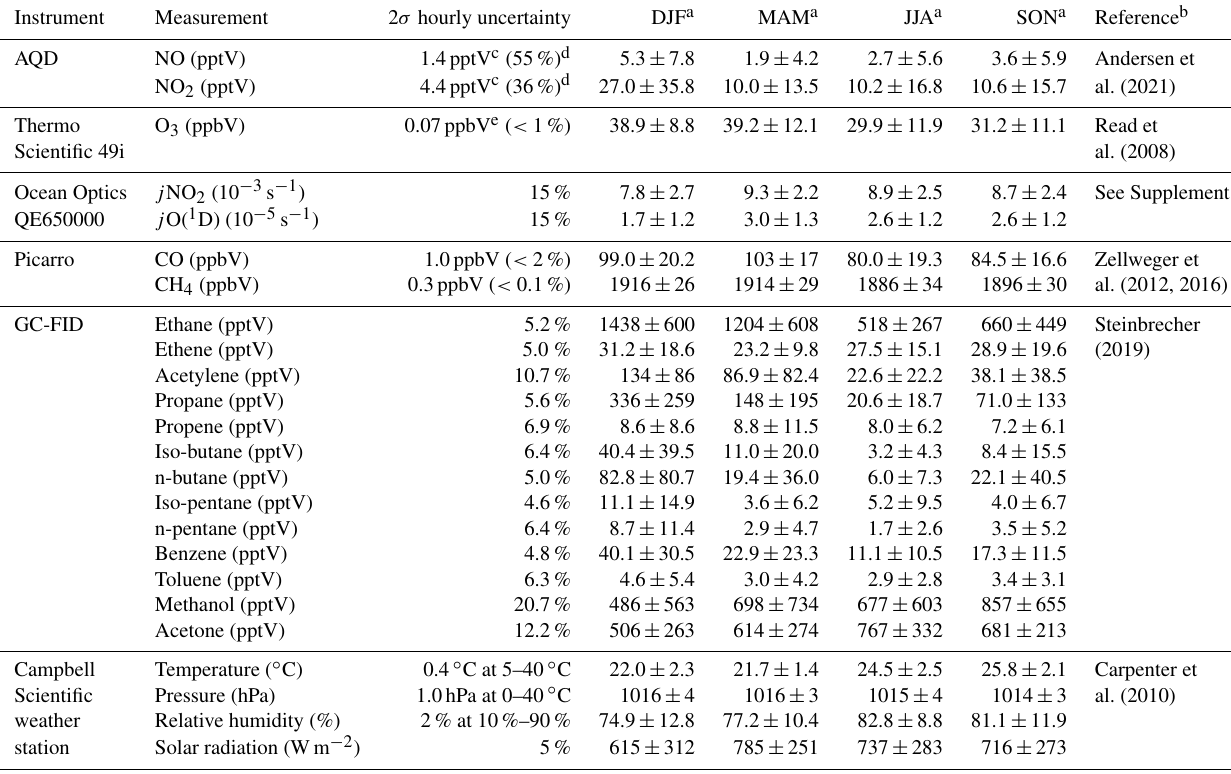
Table 2. Overview of instruments and measurements used from the CVAO.